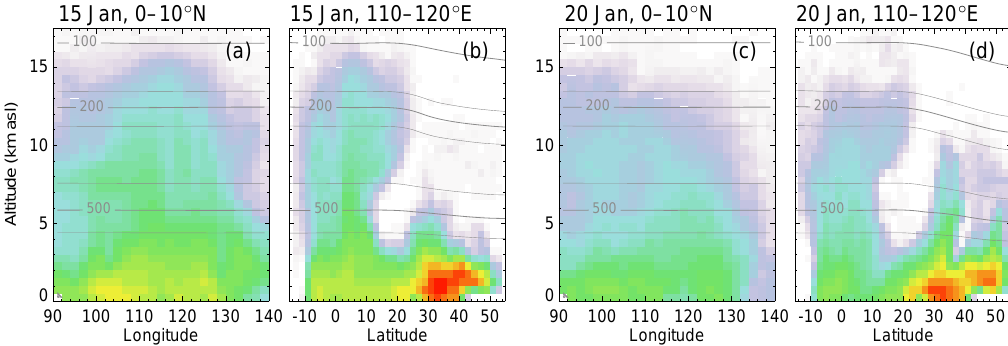
Figure 6. Time-integrated particle (i.e. trajectory) density resulting from a midlatitude particle source in NAME, on 15 and 20 January 2009 (marked with dashed lines in Fig. 5). The colour scale is the same as in Fig. 5. (a) shows a longitude–altitude cross section for 15 January 2009, averaged over 0–10 ◦ N. (b) shows a latitude–altitude cross section, also for 15 January 2009, and averaged over 110–120 ◦ E. (c) and (d) show the same for 20 January 2009. The altitude scale is kilometres above sea level (a.s.l.). Pressure contours (in hPa) from NAME’s driving meteorological data are marked with grey lines (contours without labels bound the pressure ranges used in Fig.